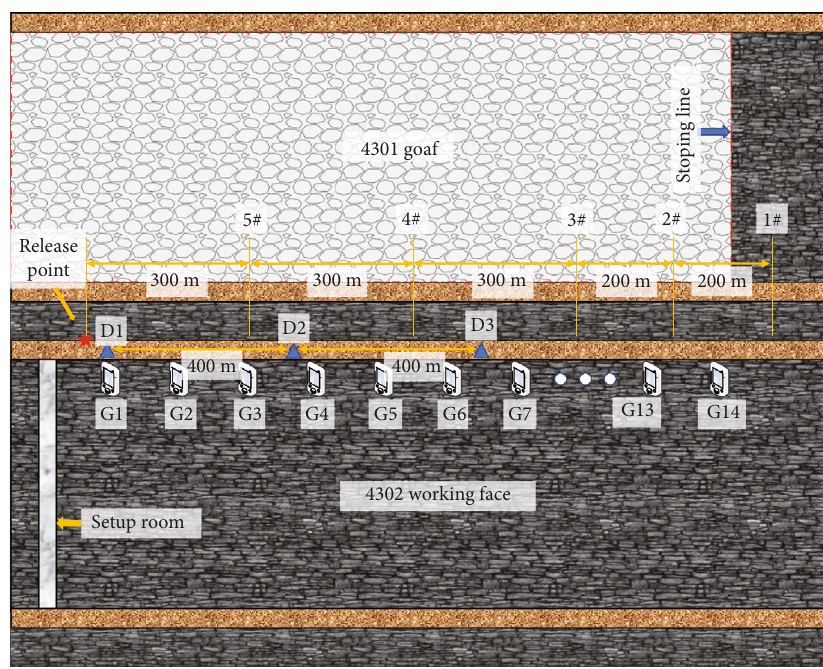
Figure 7: Site layout of coal pillar air leakage and oxidation